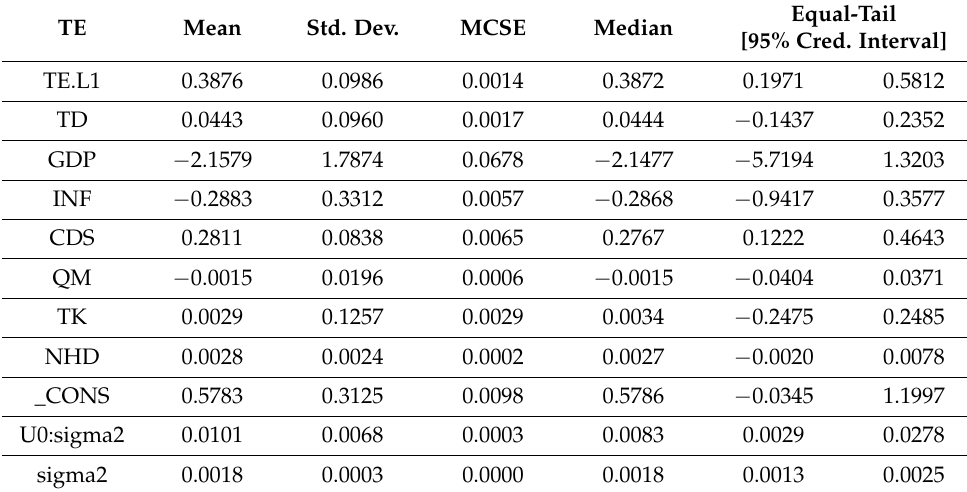
Table 5. The estimation result of Model (1) by the Bayesian method. TE Mean Std.